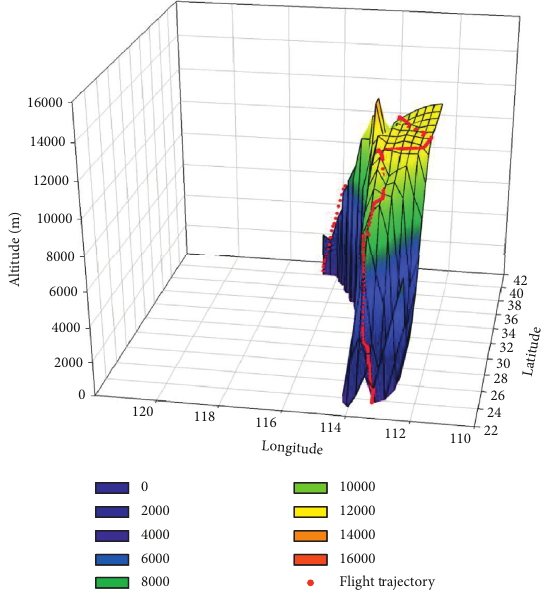
Figure 5: The flight profile for calculating A330-200 between Beijing and